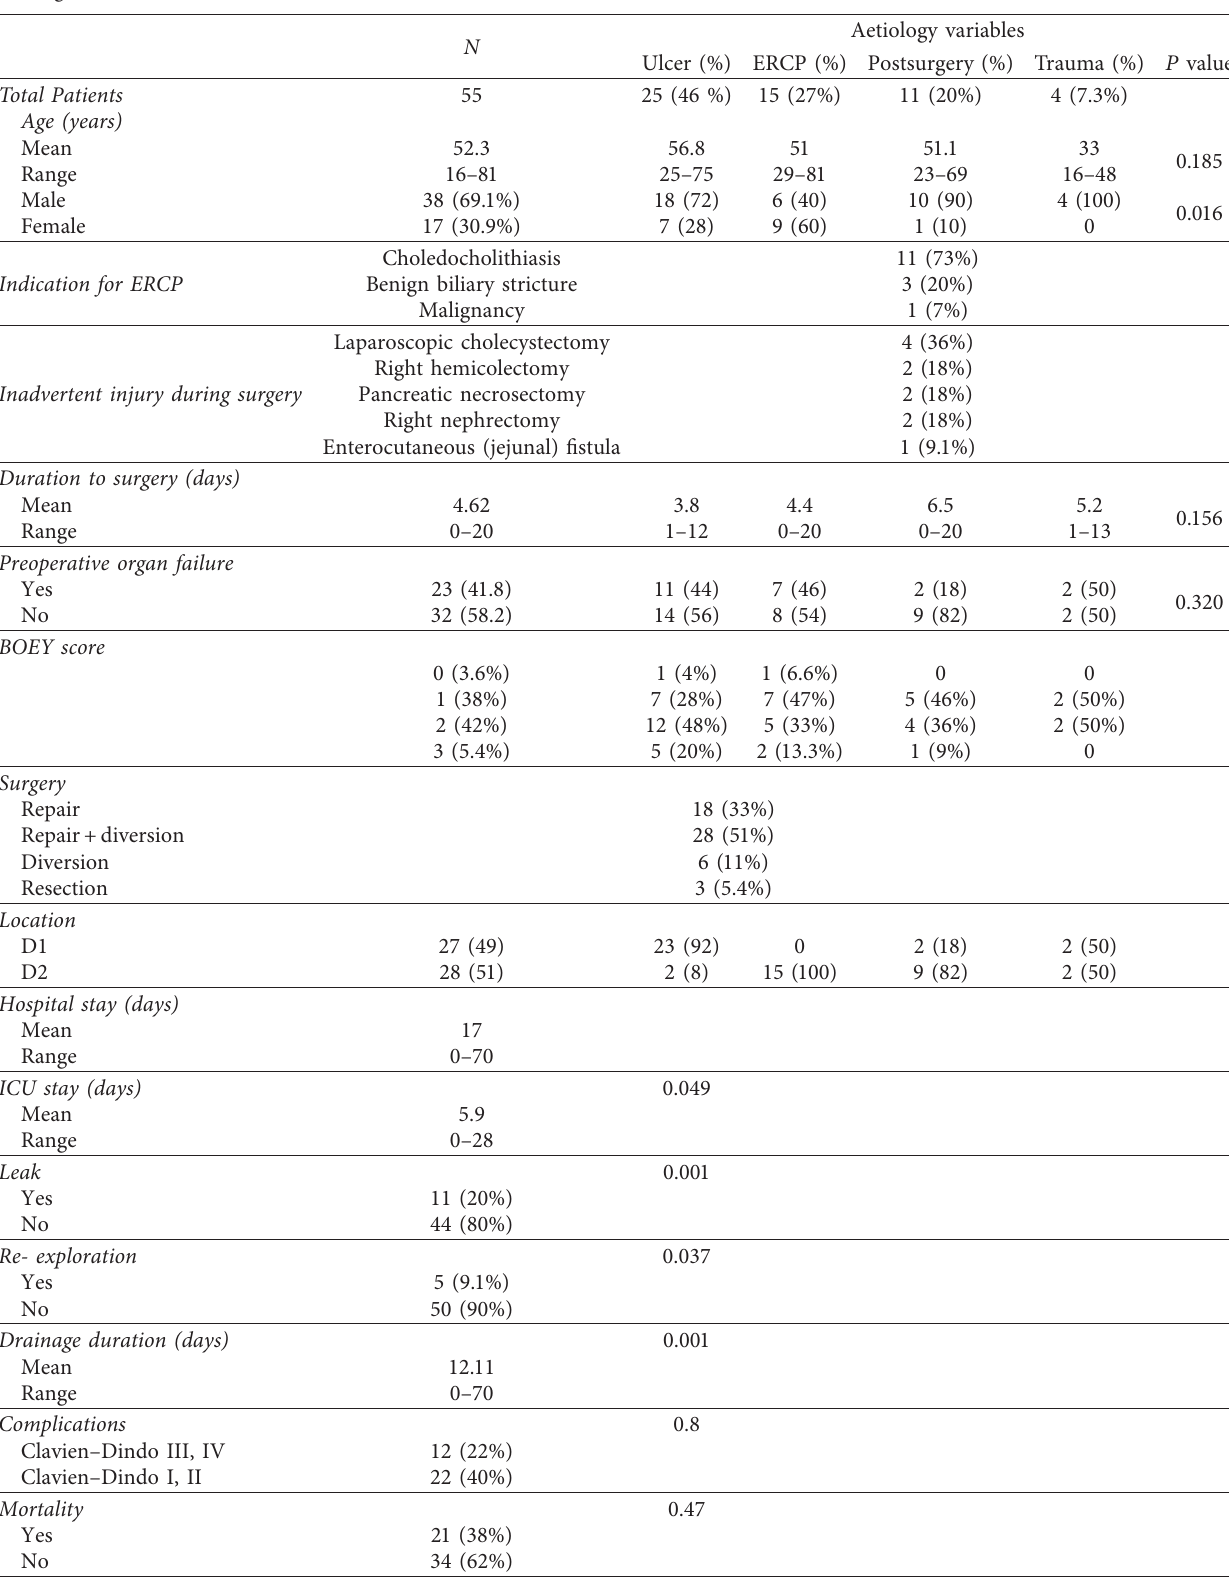
Table 1: Demographic data, preoperative, intraoperative, and postoperative variables, and outcomes of duodenal perforation. Association of aetiological factors with outcome